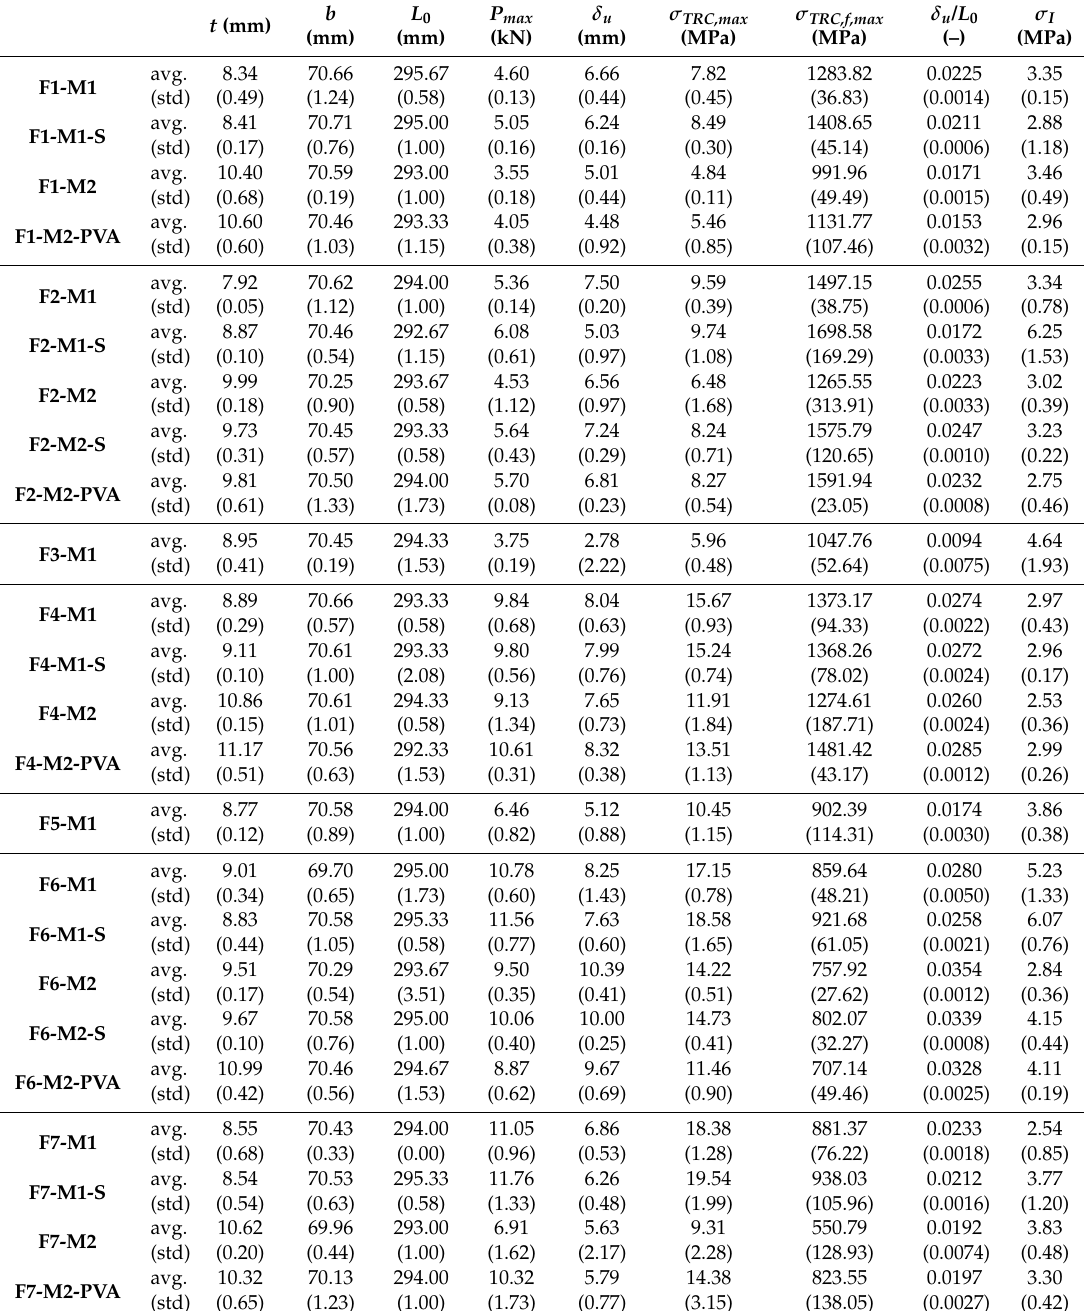
Table 7. Tensile test results for TRC composites: average values (avg.) and standard deviations